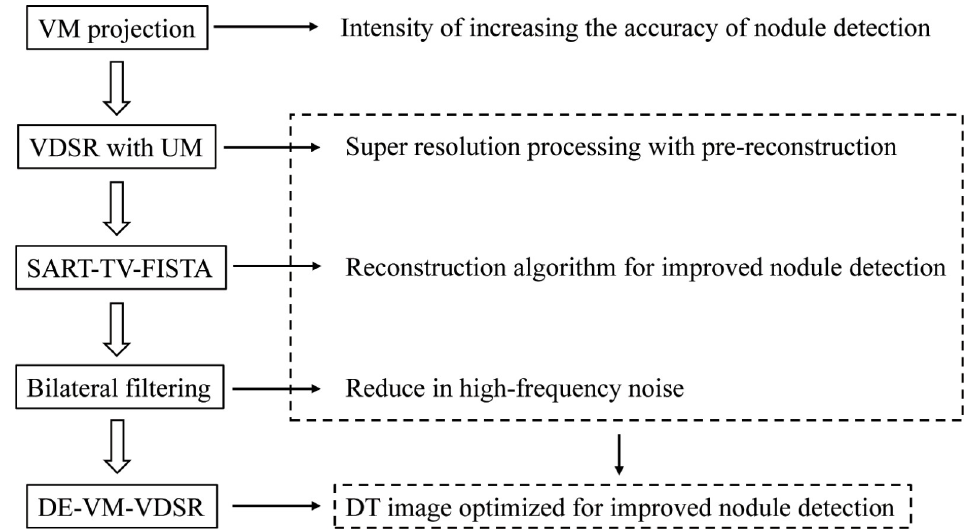
Fig 2. Overview and interrelation of each algorithm. The relation between very-deep super-resolution (VDSR) with unsharp masking (UM), the simultaneous algebraic reconstruction technique total-variation first-iterative shrinkage– thresholding algorithm (SART–TV–FISTA), and bilateral filtering (BF), which are the cores of the reconstruction